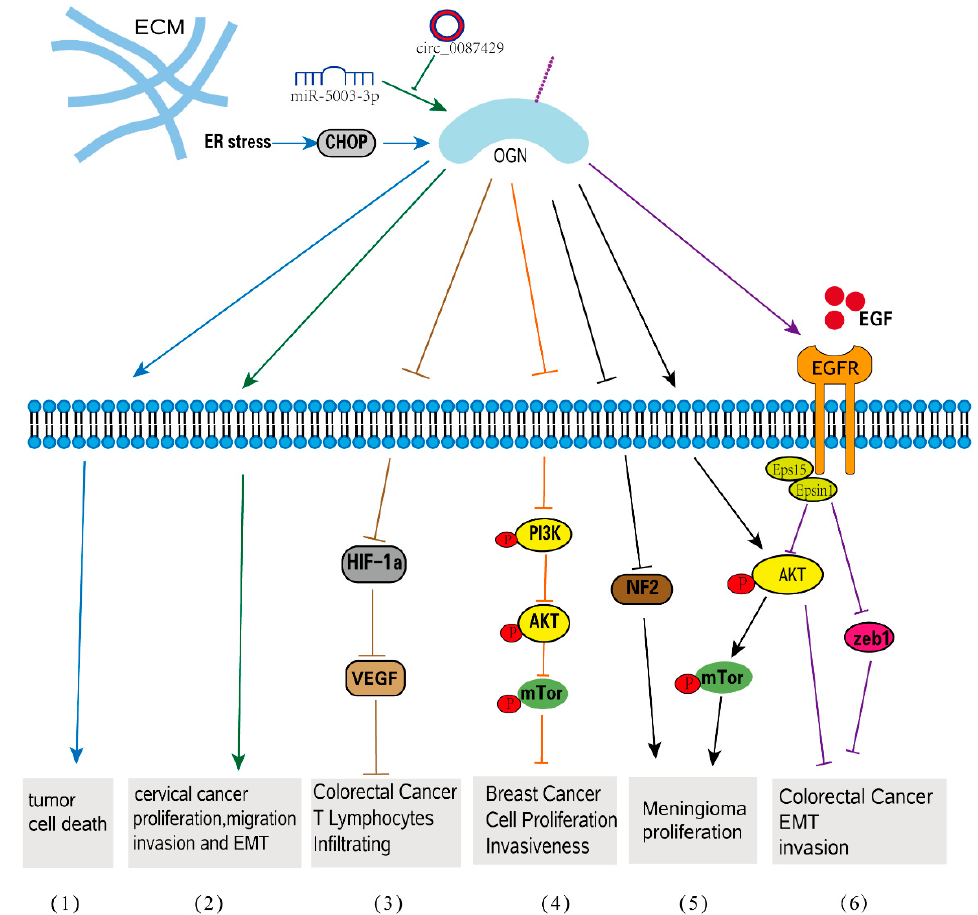
Figure 3. OGN signaling in tumorigenesis. (1) ER stress increases OGN expression and subsequent tumor cell death. (2) circ_0087429 can reverse EMT and inhibit the progression of cervical cancer via miR-5003-3p-dependent upregulation of OGN expression. (3) In colorectal cancer, OGN en- hances T lymphocyte infiltration by inhibiting the activation of HIF-1 α and significantly inhibiting the expression of VEGF. (4) OGN inhibits cell proliferation and invasiveness in breast cancer via the PI3K/Akt/mTOR signaling pathway. (5) OGN promotes meningioma development through downregulation of NF2 and activation of mTOR signaling. (6) OGN reverses EMT and invasiveness in colorectal cancer via the EGFR/Akt/zeb1